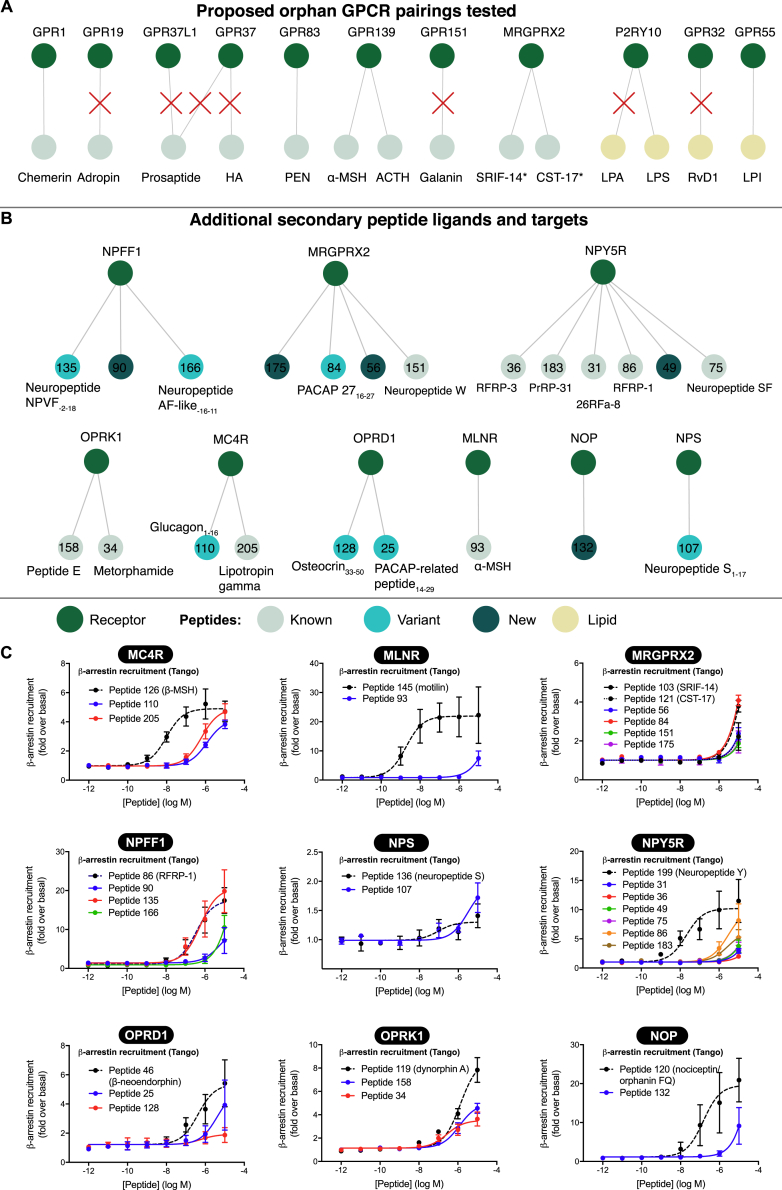
Confirmation of Proposed Pairings and Secondary Ligands for Known Peptide Receptors, Related to Figure 7(A) Of the 14 pairings proposed in literature, half were reproduced in mass redistribution and/or internalization assays (Table S5). Note: P2RY10–lysophosphatidylserine (LPS) activity was marginal. ∗We tested cleavage variants of cortistatin (CST-14) and somatostatin (SRIF-28).(B-C), Nine known peptide receptors were activated by their cognate agonists (internal controls) and, unexpectedly, 22 additional peptides. These indicate as yet unappreciated cross-pharmacology (Table S7). All data represent mean ± SEM for n = 3 independent experiments performed in triplicate.